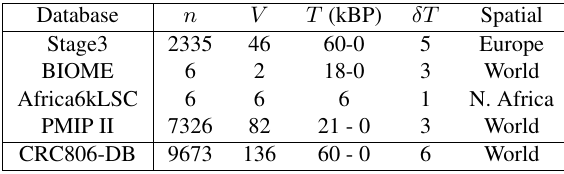
Table 2: Key numbers describing the integrated palaeoenviron- mental databases, n = derived spatial datasets. V = environmen- tal variables, T = temporal extent (oldest to youngest) in kBP. δT = temporal periods. Spatial = spatial